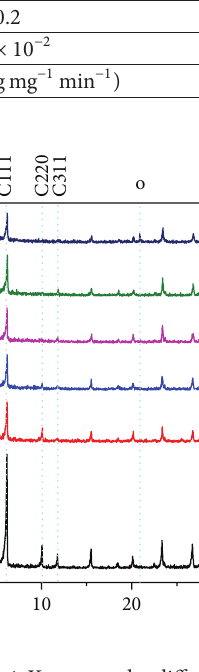
Figure 4: X-ray powder diffraction patterns of NaX and 0.1-NaCoX thermallytreatedzeolites:thermallyuntreatedsampleNaCoX-0and the samples treated at 400 ∘ C for 3 h (0.1-NaCoX-1), 500 ∘ C for 3 h (0.1-NaCoX-2), 600 ∘ C for 3 h (0.1-NaCoX-3), and 700 ∘ C for 3h (0.1-